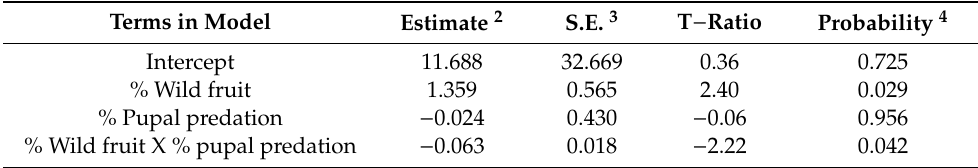
Table 3. Predictive model for determining cumulative relative abundance 1 of D. suzukii per Table 1. by the end of 2018 growing season.